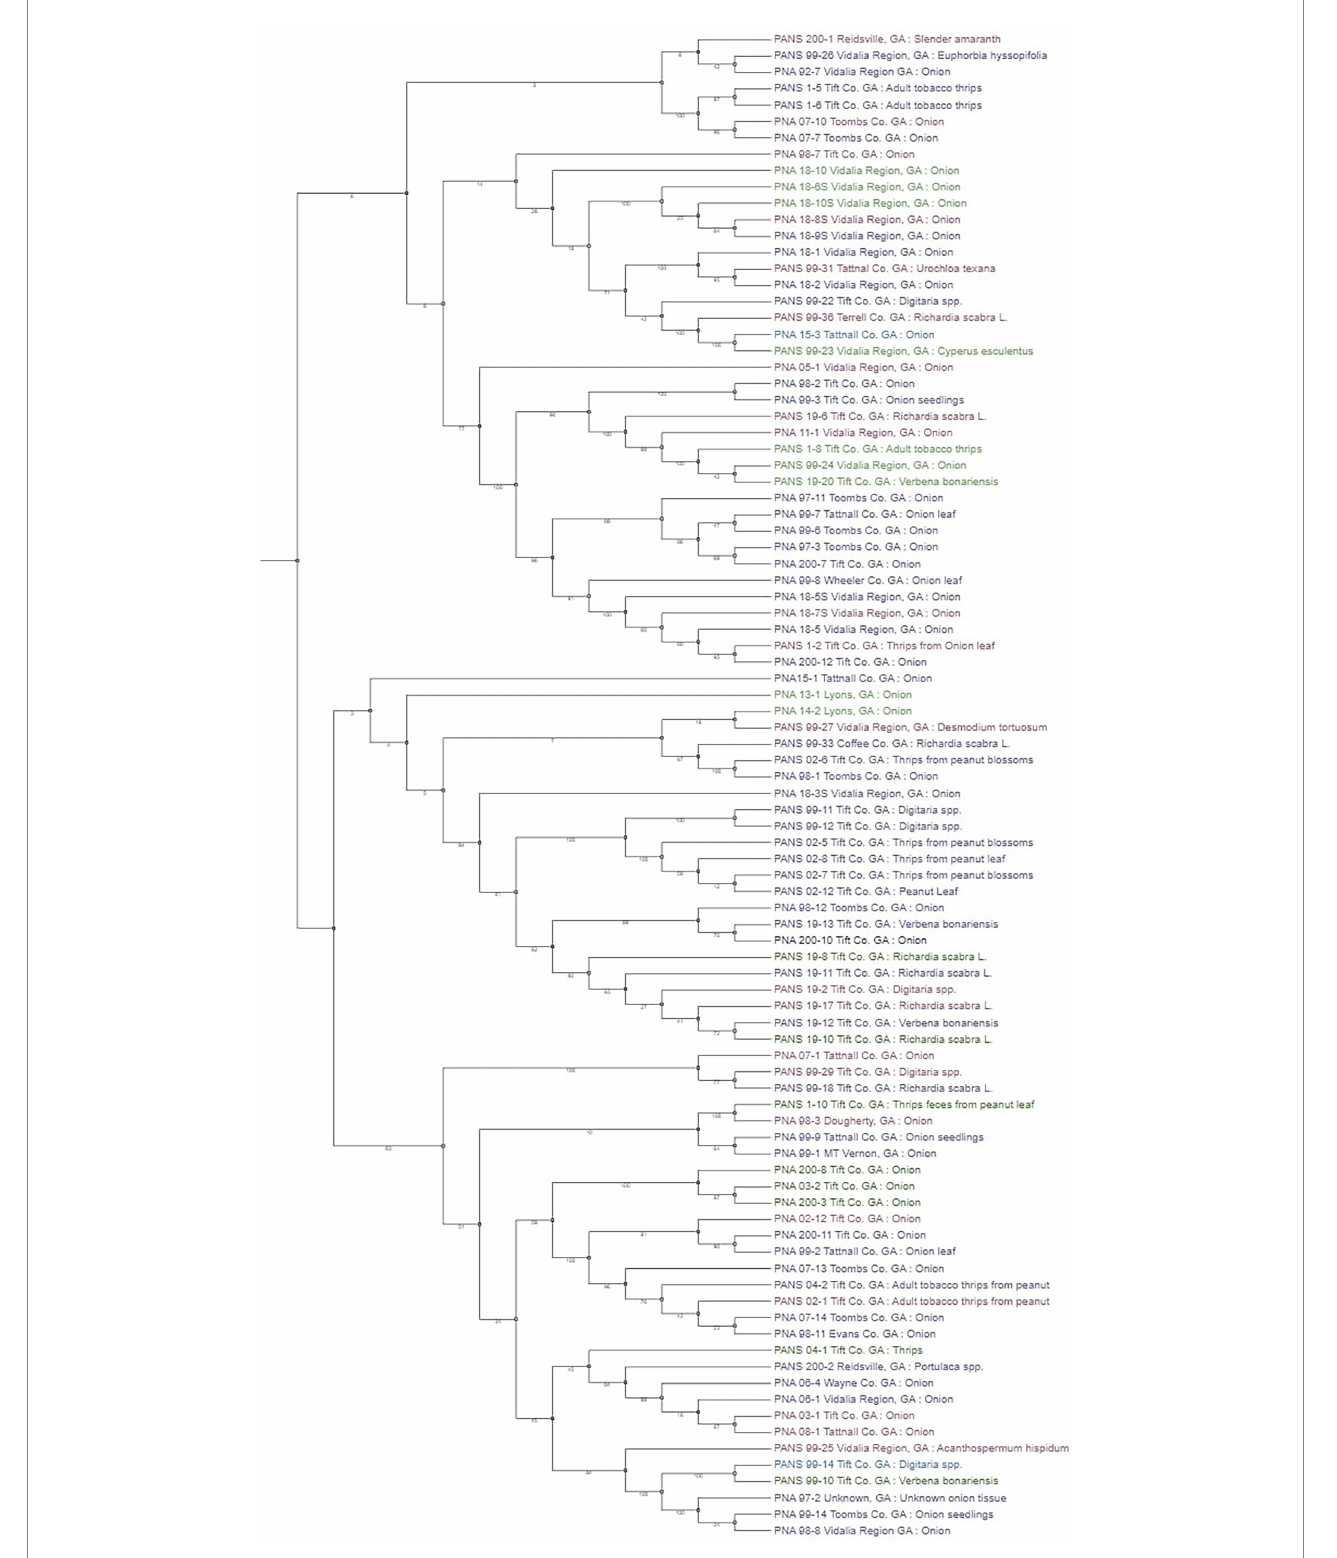
FIGURE 4 Phylogenetic tree based on core single nucleotide polymorphism (SNP) variants of genes among the Pantoea ananatis strains. Strains color coded in green are non-pathogenic on Allium porrum (cv. King Richard) and A. fistulosum × A. cepa (cv. Guardsman); strains that are color-coded in purple are pathogenic on both hosts; blue coded strains are pathogenic on A. porrum only; and pink coded strains are pathogenic on A. fistulosum × A. cepa only. Bootstrap values are shown on each branch after 10,000